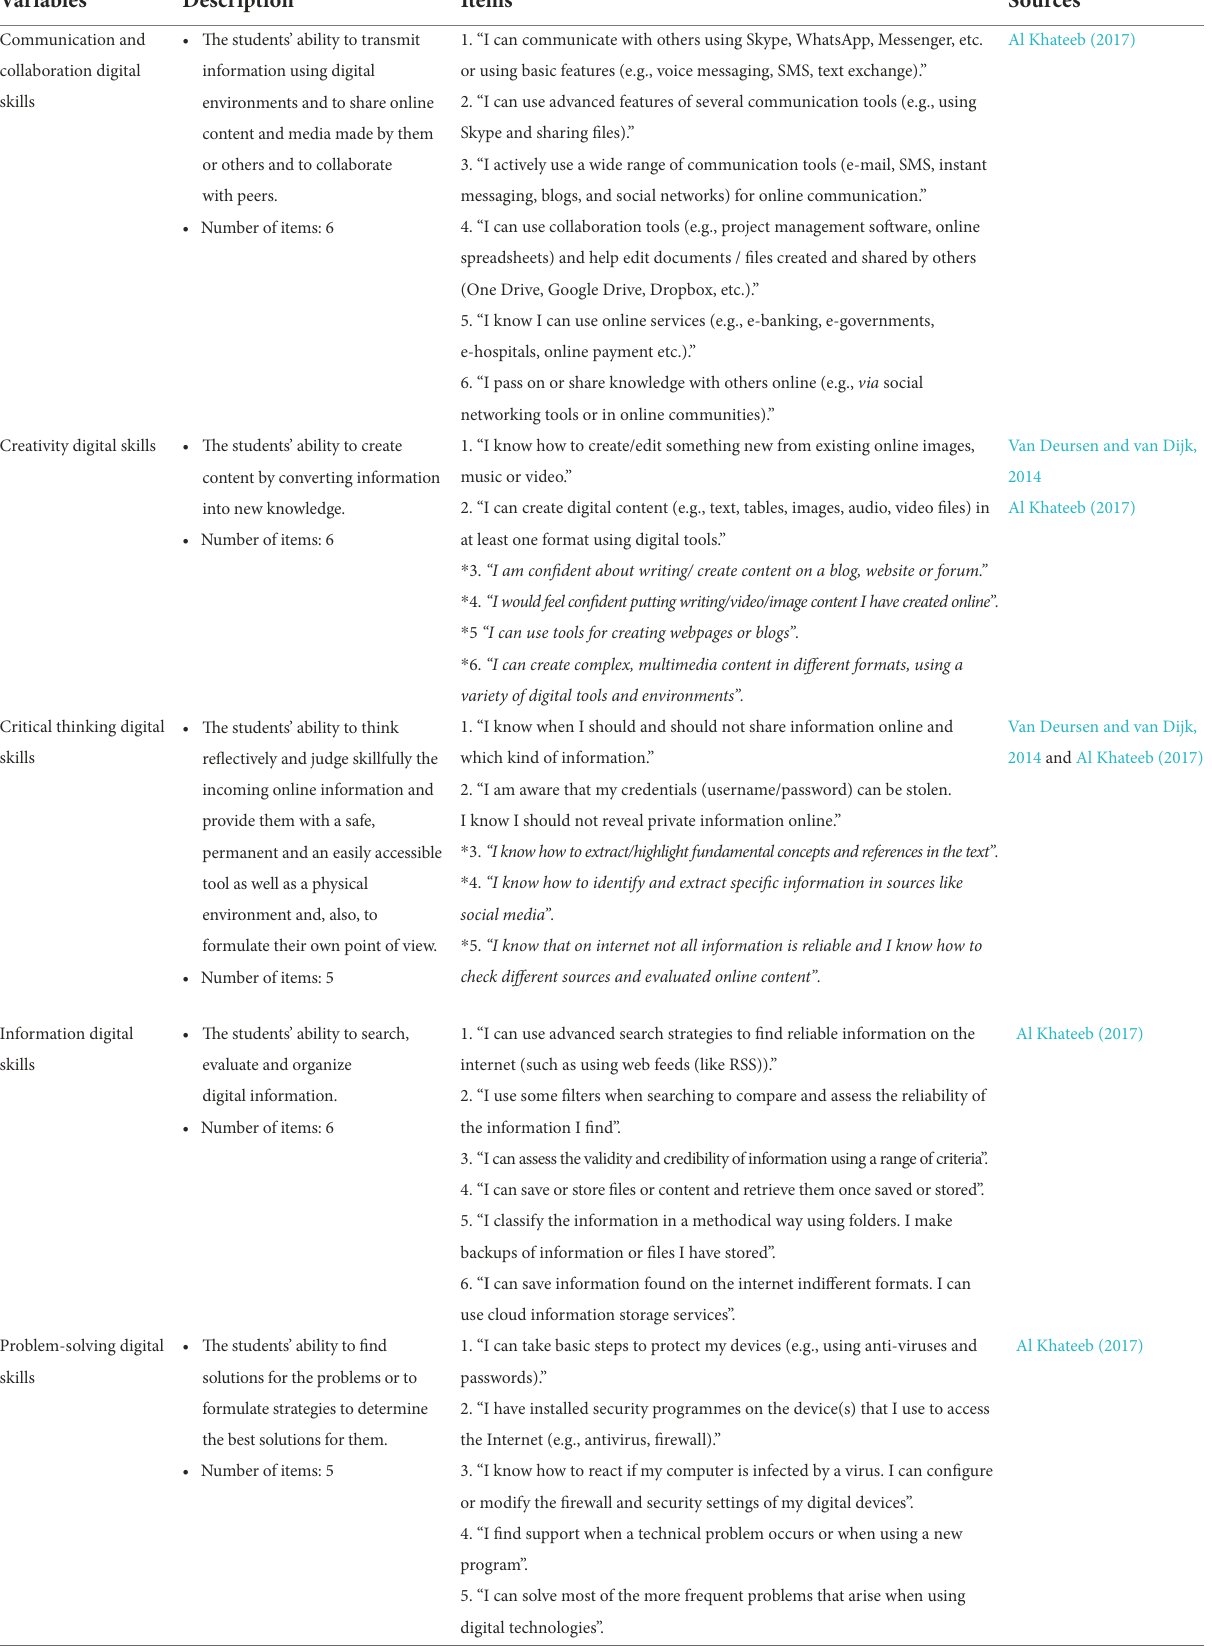
TABLE 1 Description of the variables.